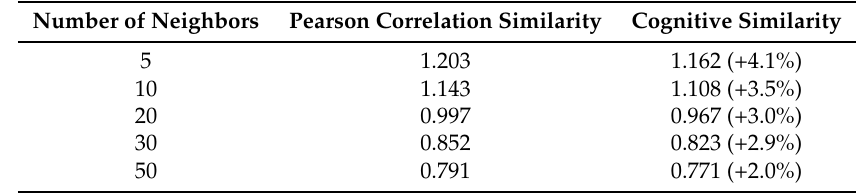
Table 4. Comparison between CF-Pearson Correlation Similarity and the CF-Cognitive Similarity with varying neighborhood sizes (RMSE